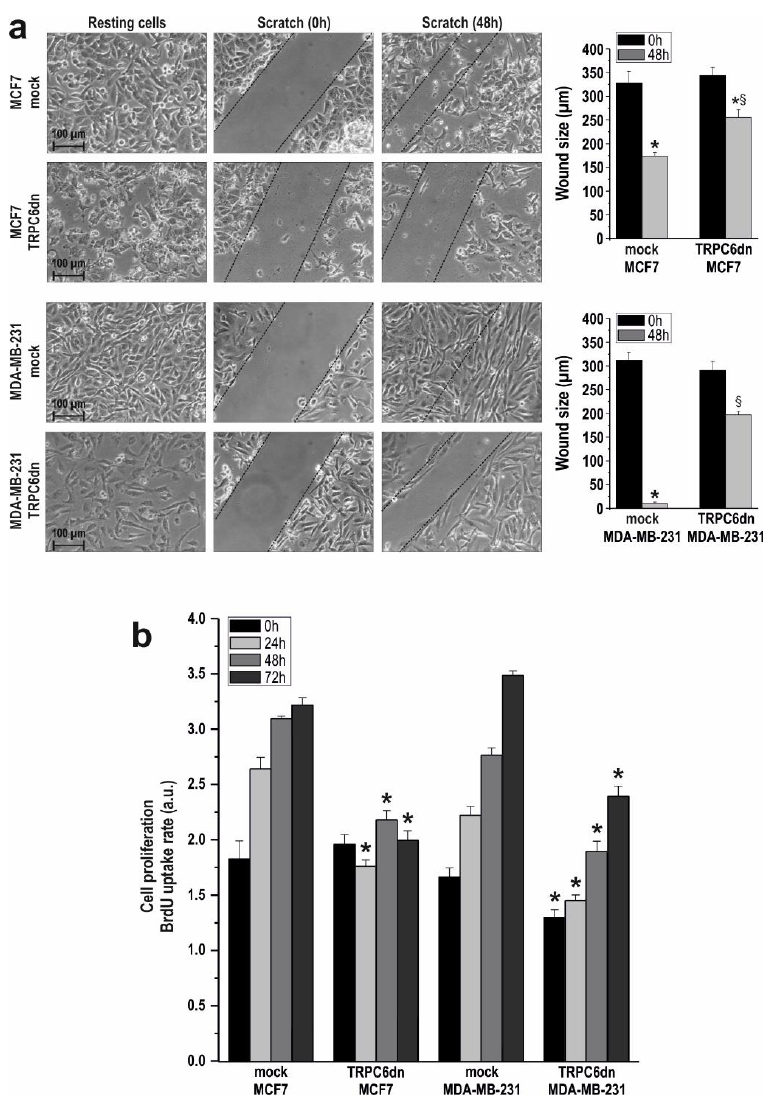
Figure 4. Expression of TRPC6dn mutant attenuates cell migration and proliferation in breast cancer cells. ( a ) MCF7 and MDA-MB-231 cells were transfected with TRPC6dn expression plasmid or empty vector (mock), as indicated. Forty-eight hours after transfection cells were subjected to wound healing assay as described in Methods. Images were acquired at 0 and 48 h from the beginning of the assay. The dotted lines define the areas lacking cells. The bar graphs represent the wound size, in micrometers, at the different conditions, expressed as the mean ± SEM of three independent experiments. * p < 0.05 compared to the time = 0h. § p < 0.05 compared to the corresponding time in mock-treated cells. ( b ) MCF7 and MDA-MB-231 cells were transfected with TRPC6dn expression plasmid or empty vector (mock), as indicated, and 48 h later cell proliferation was assessed for a further 24, 48 and 72 h using the BrdU cell proliferation assay kit, as described in the Material and Methods. Bar graphs represent cell proliferation 0, 24, 48 and 72 h after cell transfection, presented as BrdU uptake rate. * p < 0.05 compared to the corresponding control (mock-transfected cells).